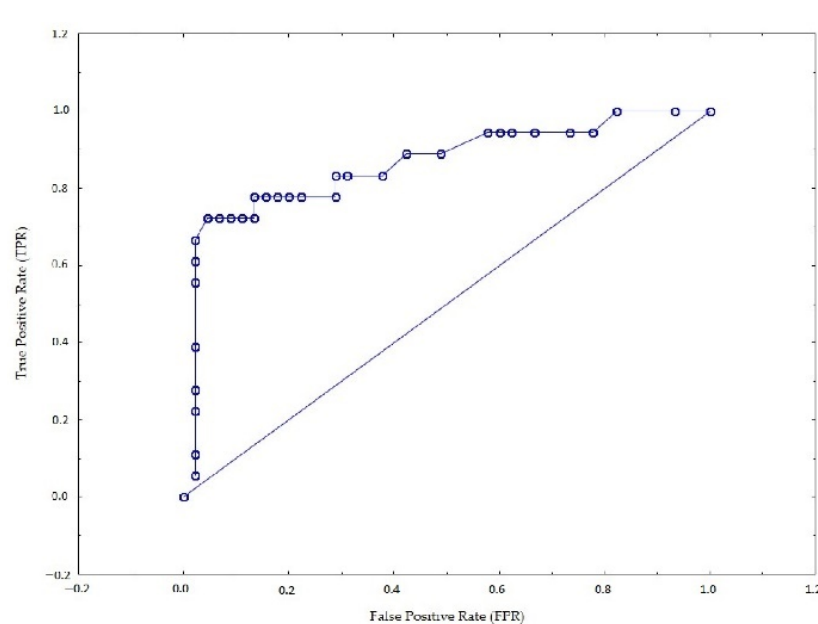
Figure 7. ROC curve for 2nd model.